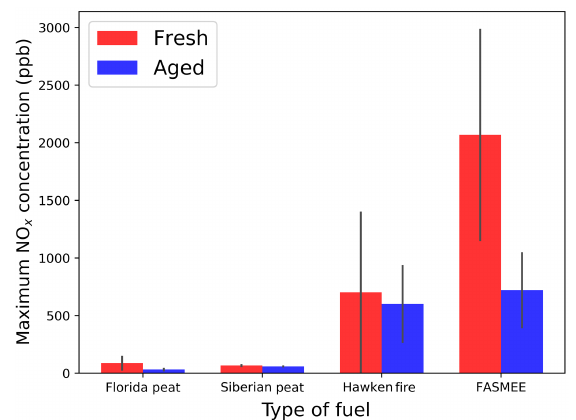
Figure 4. Maximum NO x concentration for emissions from the combustion of different fuels. Average values from replicates plot- ted as bars; error bars are standard deviations of the mean from three replicate burnings for each